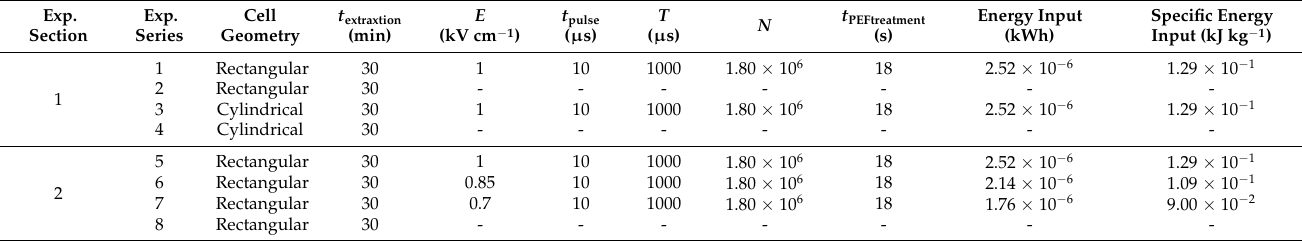
Table 1. PEF process optimization study